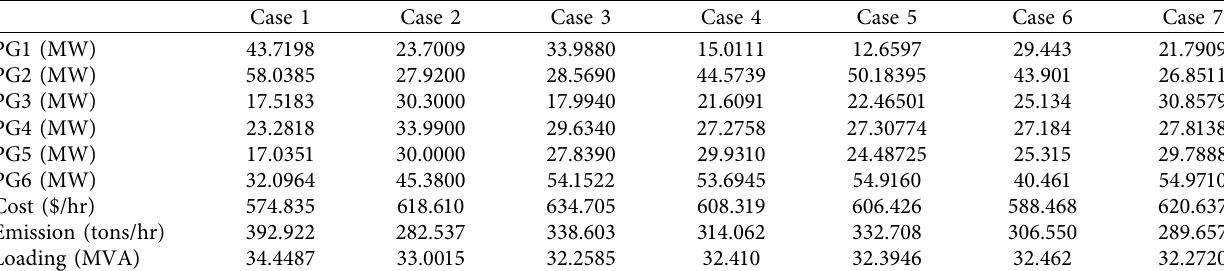
Table 4: Optimized variables for strategy A